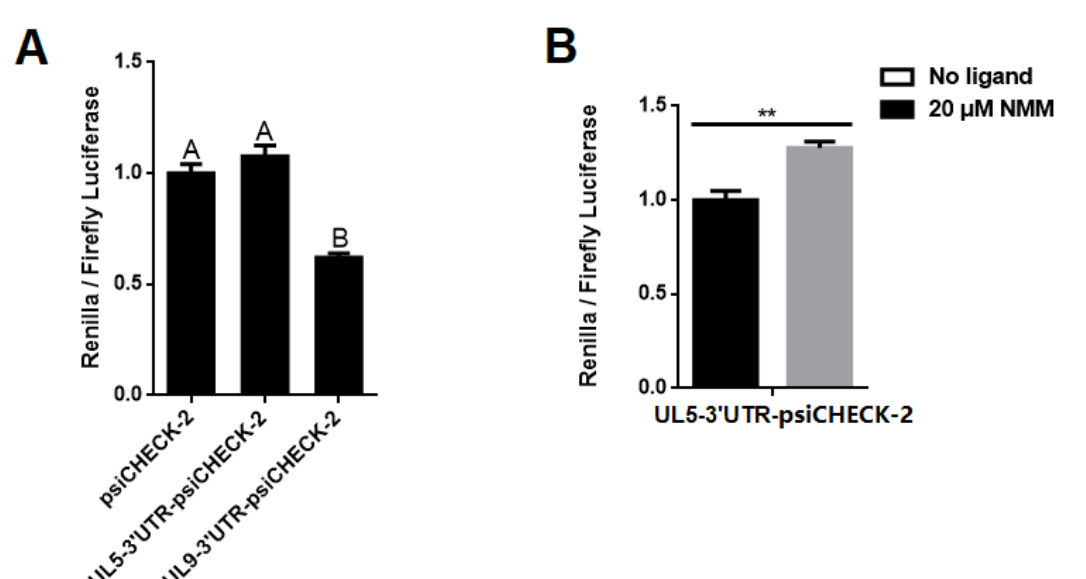
Figure 10. G 2 -PQSs from UL5-3 ′ UTR and UL9-3 ′ UTR are sensitive to cations and ligands. ( A ) CD